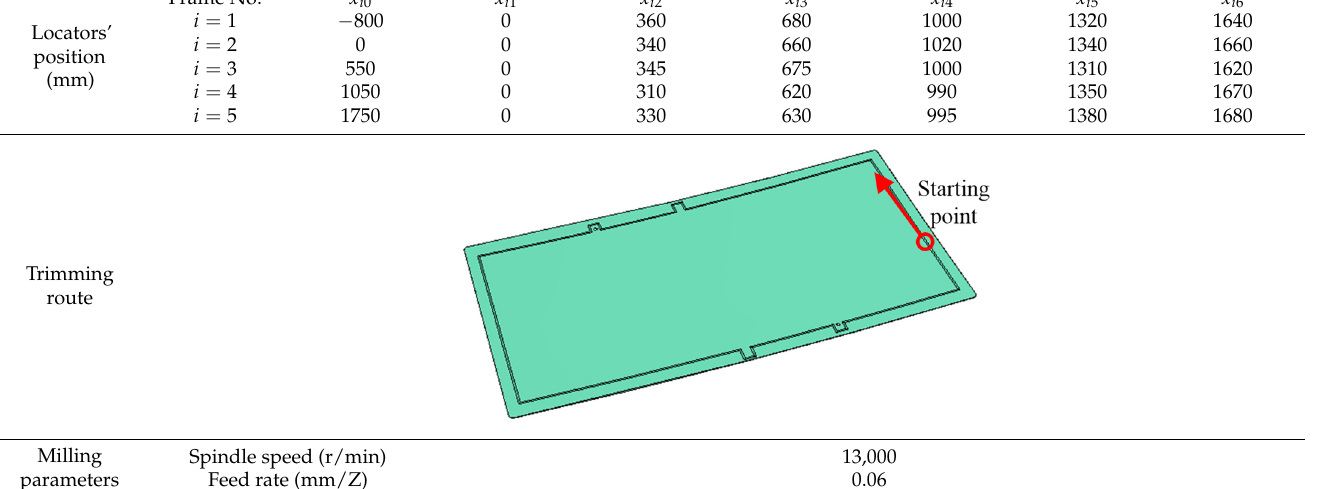
Figure 7a,b show the in-operation trimming process. The real-time displacements